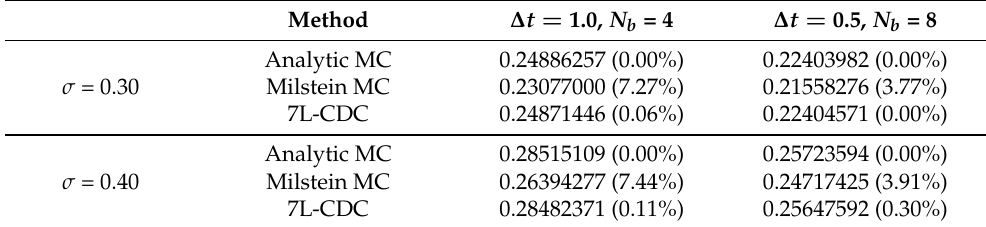
Table 4. Pricing Asian European-style option with a fixed strike price, using Y 0 = 1.0, ˜ K = Y 0 , r = 0.1, T = ∆ t × N b , the number of sample paths M =